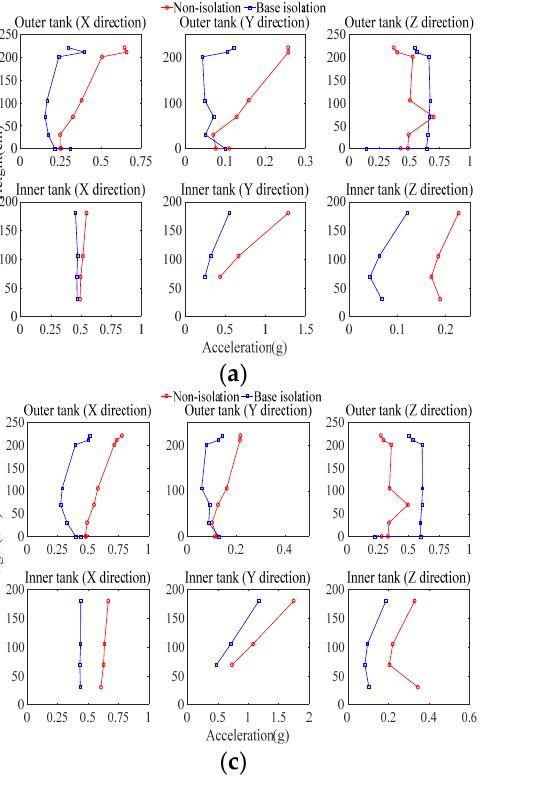
Figure 5. Comparison of acceleration response of non-isolated and isolated tanks: ( a ) Wolong wave (XZ directions, 0.25 g); ( b ) Wolong wave (XYZ directions, 0.25 g); ( c ) Wolong wave (X direction, 0.5 g); ( d ) Wolong wave (XZ directions, 0.75 g).